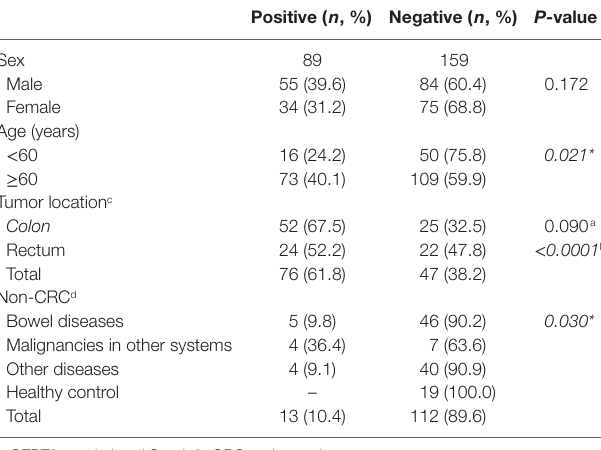
TaBle 2 | Detection results of mSEPT9 ( n = 248). TaBle 1 | Demographic and clinical features of the subjects.